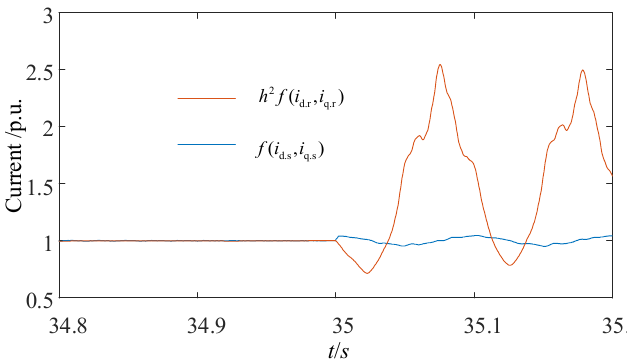
Figure 3. f ( i d.s , i q.s ) and h 2 f ( i d.r , i q.r ) obtained by Clark transform